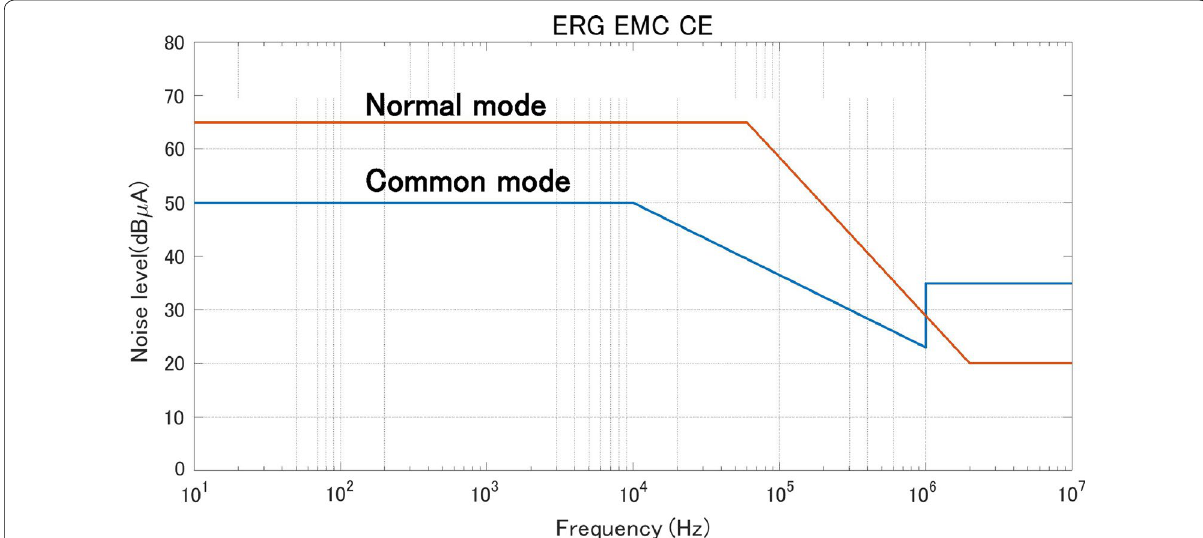
Fig. 15 Limit level for the electromagnetic compatibility (EMC) requirements of the conducted emission (CE)